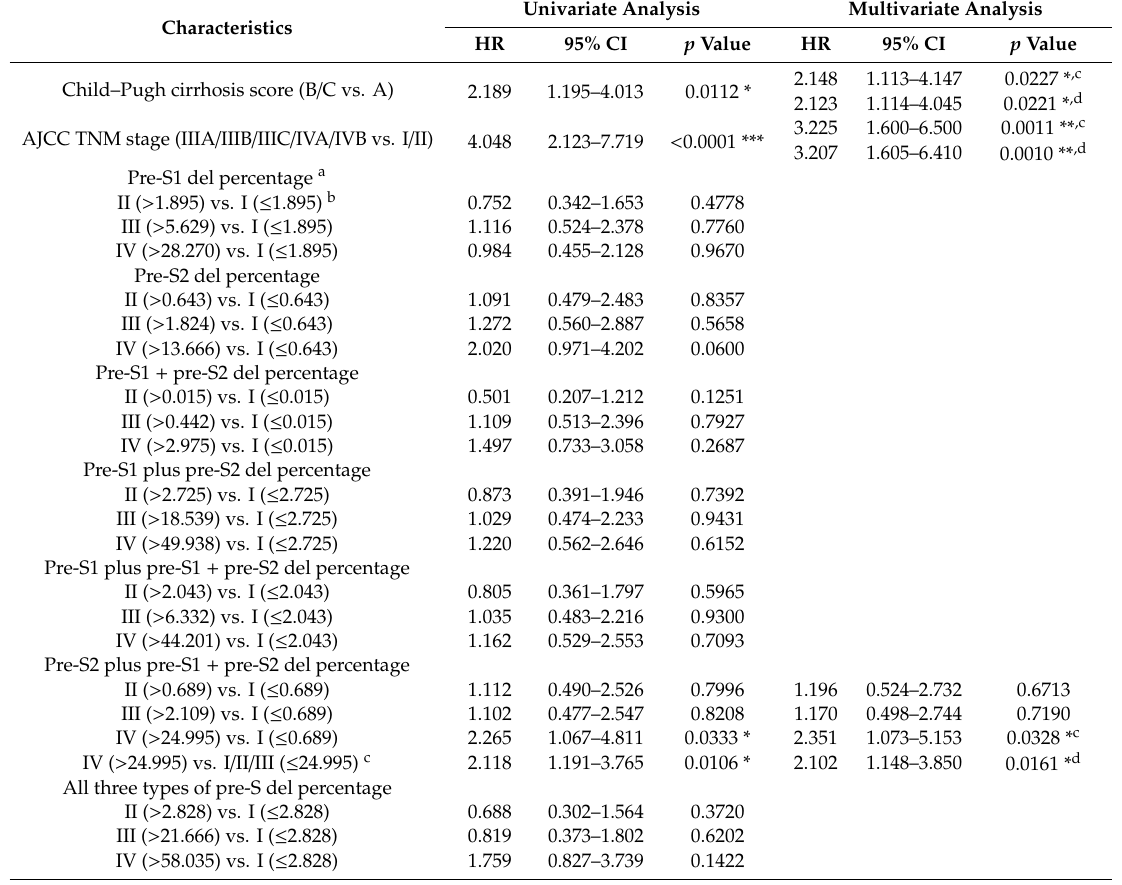
Table 4. Univariate and multivariate analyses of pre-S deletion percentage for recurrence-free survival in 75 HBV-related HCC